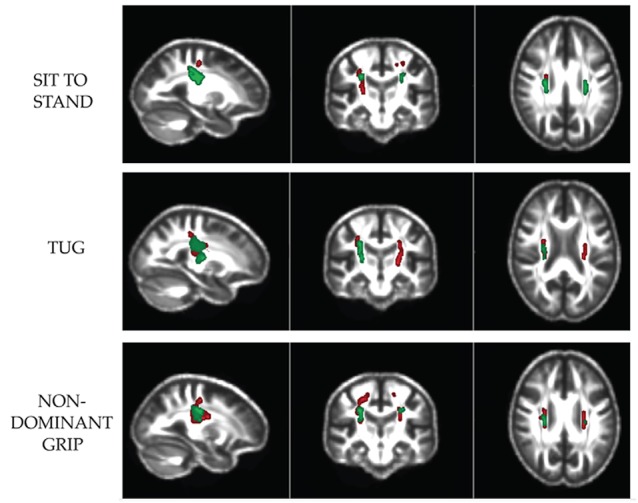
Axial, coronal and sagittal views of the significant regions (FWE p < 0.05) in the corticospinal tracts where baseline Axial Diffusivity (Green) and Fractional Anisotropy (Red) is associated with physical fitness improvement or decline over 24 months.